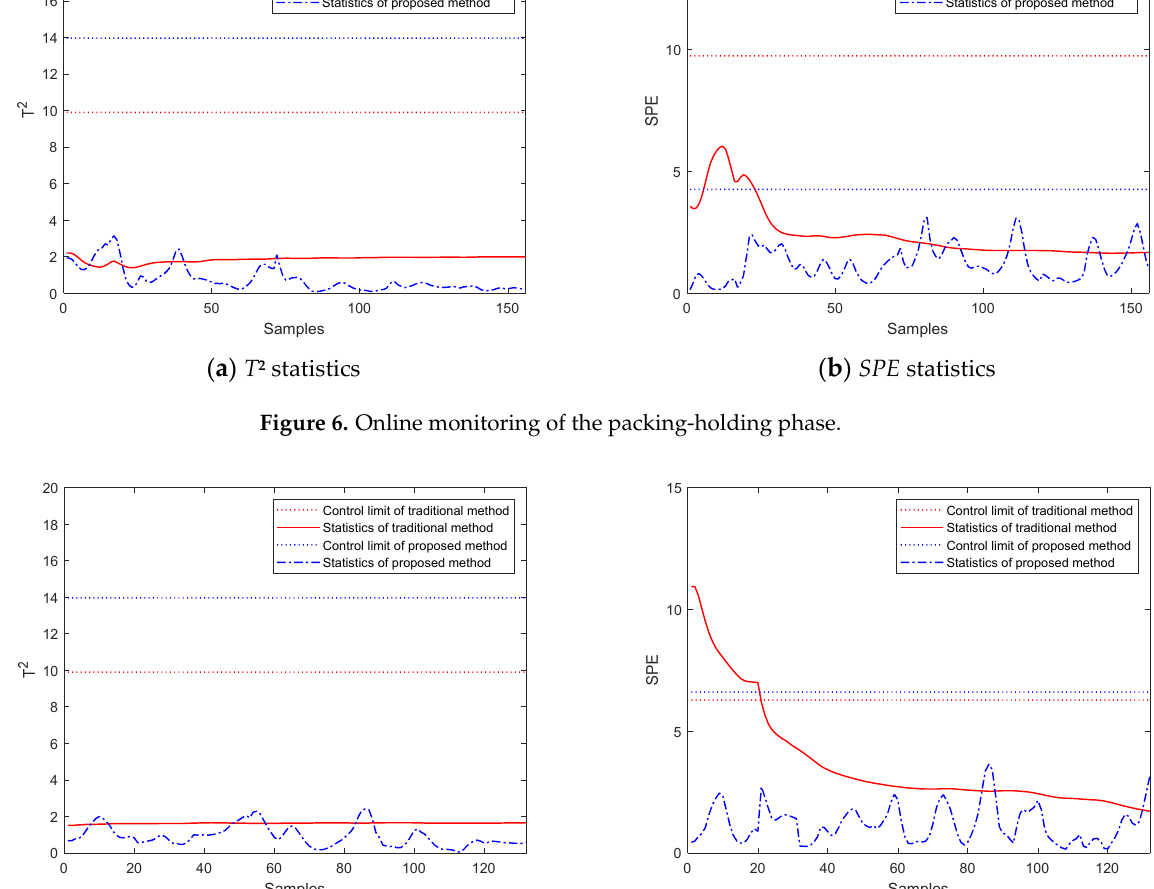
( b ) SPE statistics Figure 8. Online monitoring of the cooling phase. 3.3. Abnormal Batch Monitoring In the injection molding process, the sensor fault is one of the common faults. Because of the sensor fault, some important process variable cannot be detected, the control system cannot know the real progress, and wrong control commands may be delivered, leading to serious dangerousness of production. To simulate the sensor fault, a test batch with the pressure variable removed during the packing-holding phase is monitored. The T 2 and SPE monitoring effects of the tradi- tional method and the proposed method are shown in Figure 9, respectively. Compared with the traditional method, the amplitudes of the statistics of the proposed method are relatively larger. It can be concluded that the sensitivity of the proposed method is not affected, although it involves all quality-related phase and mode information in historical processes in the regression model, and it can identify the fault batch as fast as the tradi- tional method, with an even larger alarm signal. So, the proposed method is better than the traditional method.